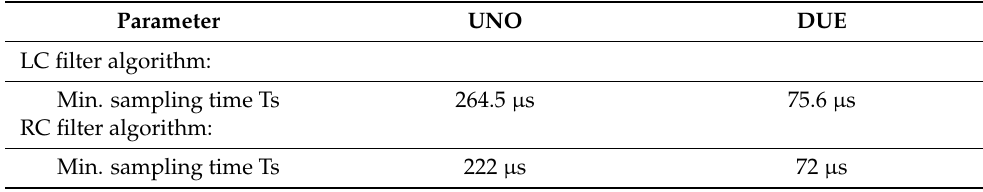
Table 2. FIR algorithms execution times according to the type of platform.